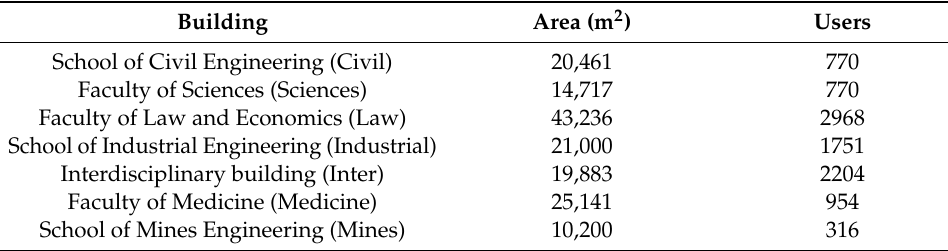
Table 1. Main characteristics of the buildings on the